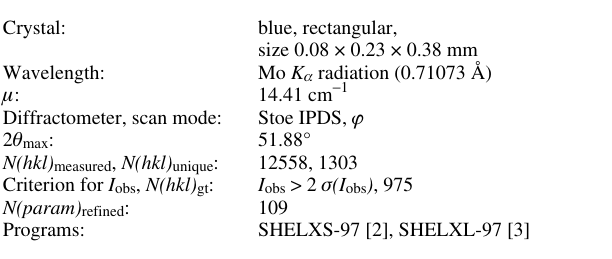
Table 1. Data collection and handling.